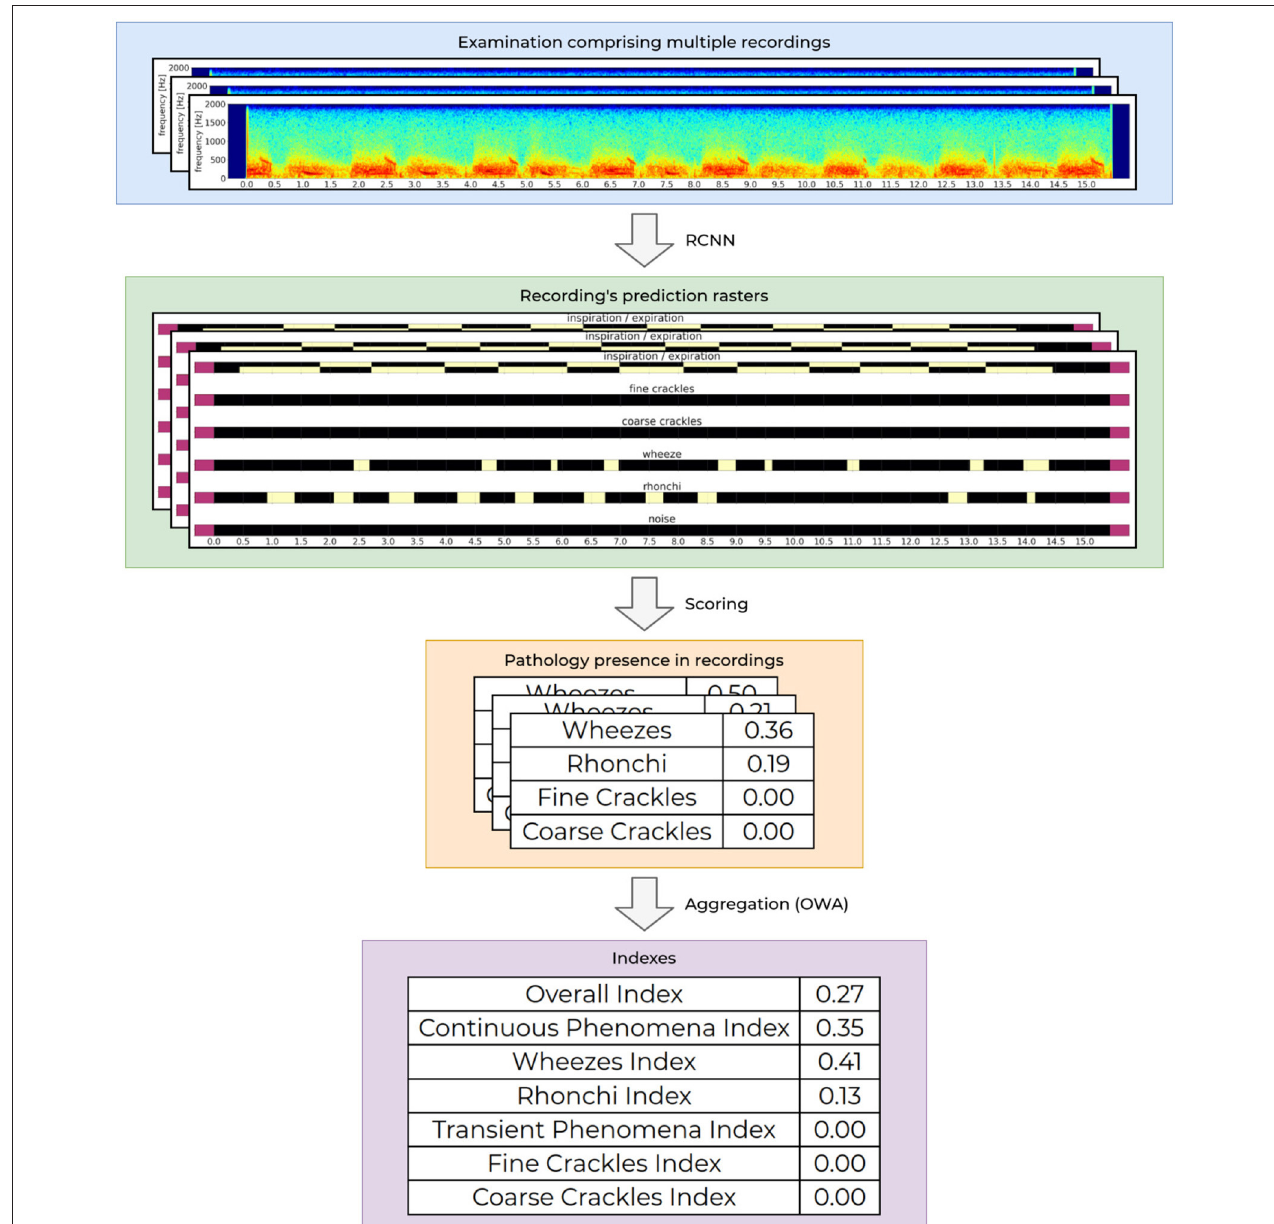
FIGURE 2 | Process of determining the indexes values. The processing starts with an audio recording acquisition and analysis, through aggregation of the analysis from one recording to calculation of the final indexes values for the entire